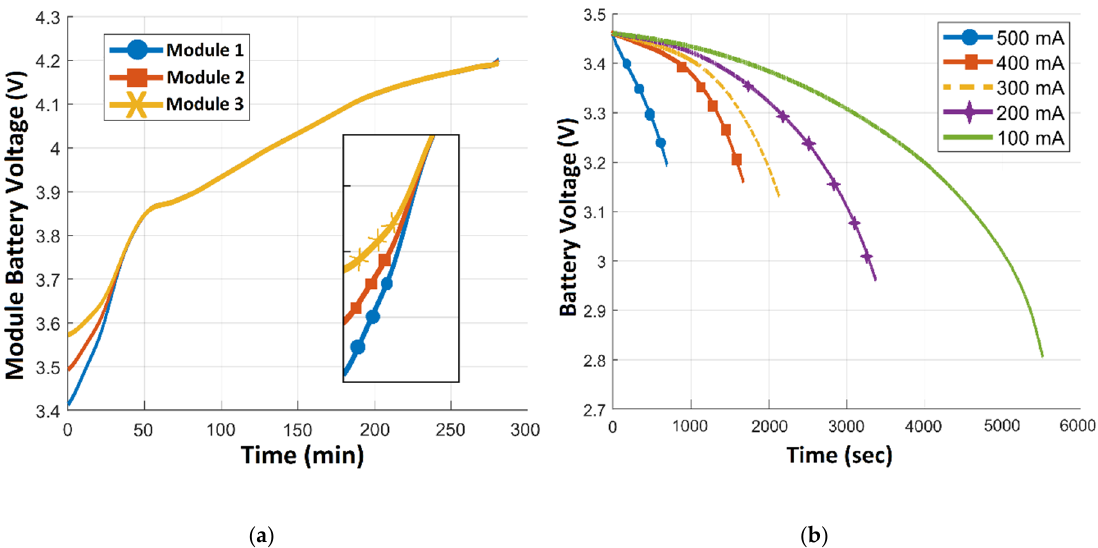
Figure 10. ( a ) Battery pack charge performance; ( b ) Battery cell discharge performance.